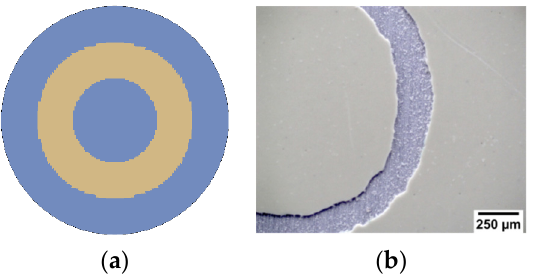
Figure 9. ( a ) A common stripping pattern predicted the model, ( b ) the experimental stripping pattern adapted from [9].